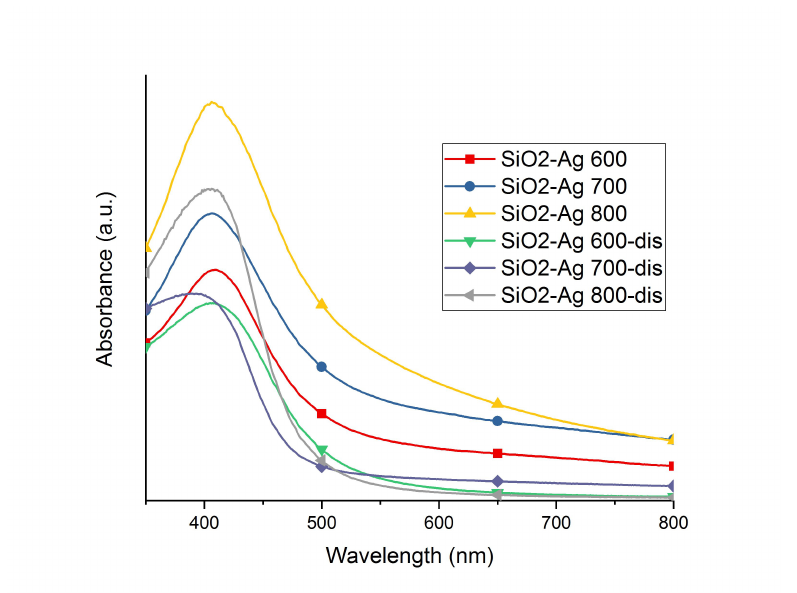
Figure A2. UV-vis spectra of SiO 2 -Ag 600, SiO 2 -Ag 700 and SiO 2 -Ag 800 with Ag dissolved by HNO 3 from the surface and SiO 2 -Ag 600, SiO 2 -Ag 700 and SiO 2 -Ag 800 powders showing the Ag plasmon peak for reference.